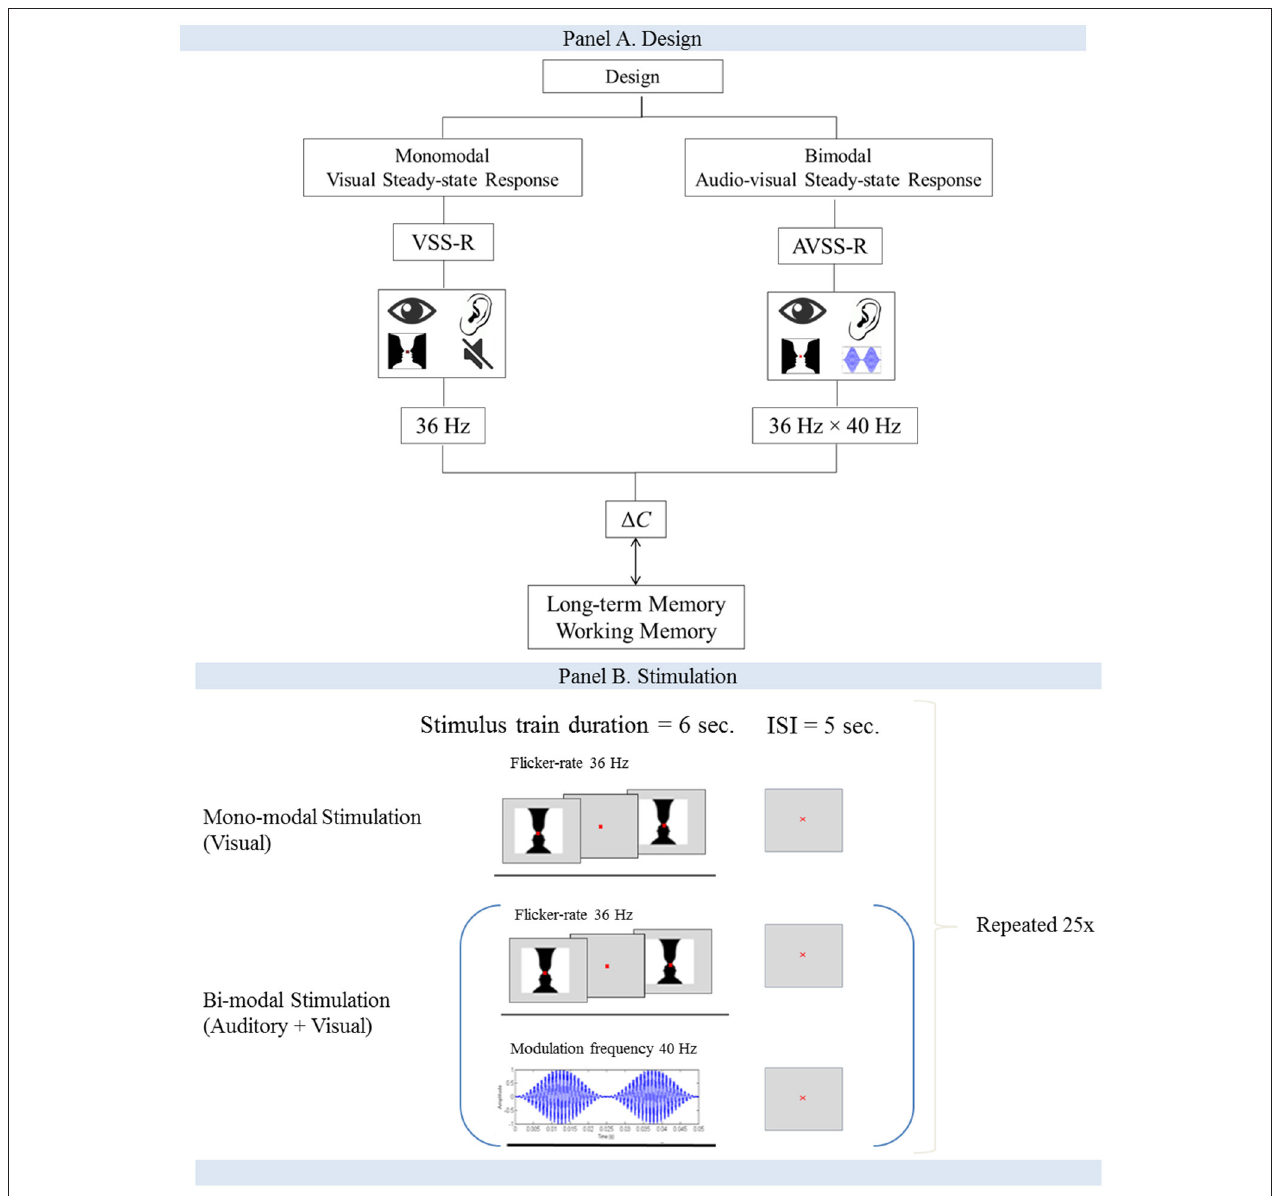
FIGURE 1 | (A,B) Flow-charts for the study design and the stimulation procedure.